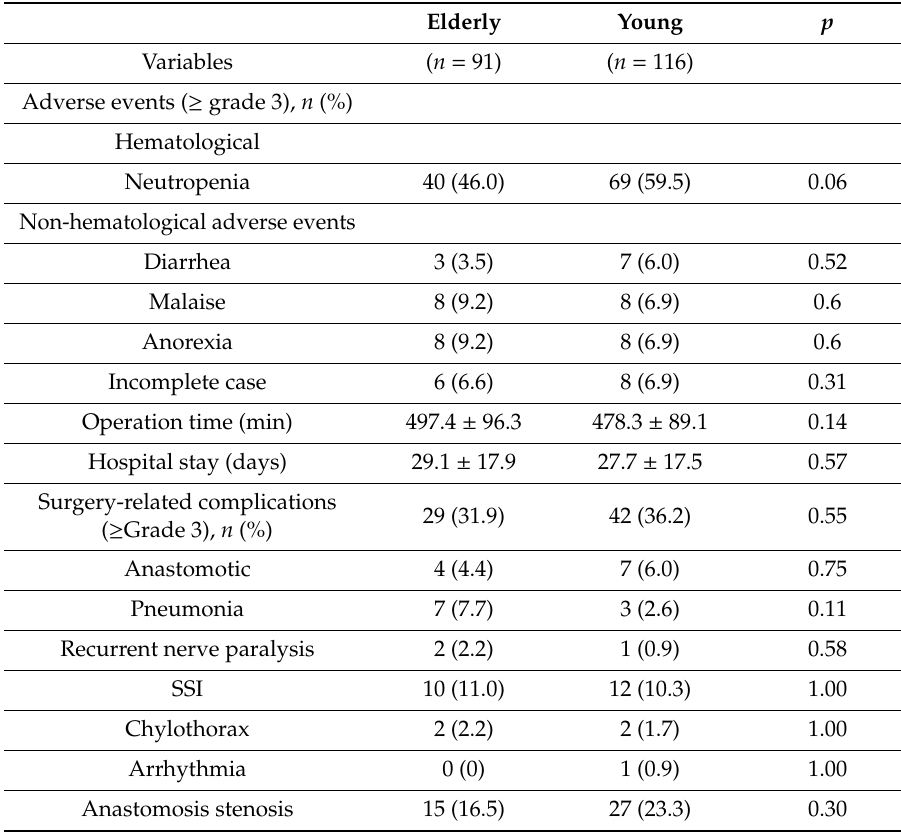
Table 2. Treatment-related factors in the elderly and young